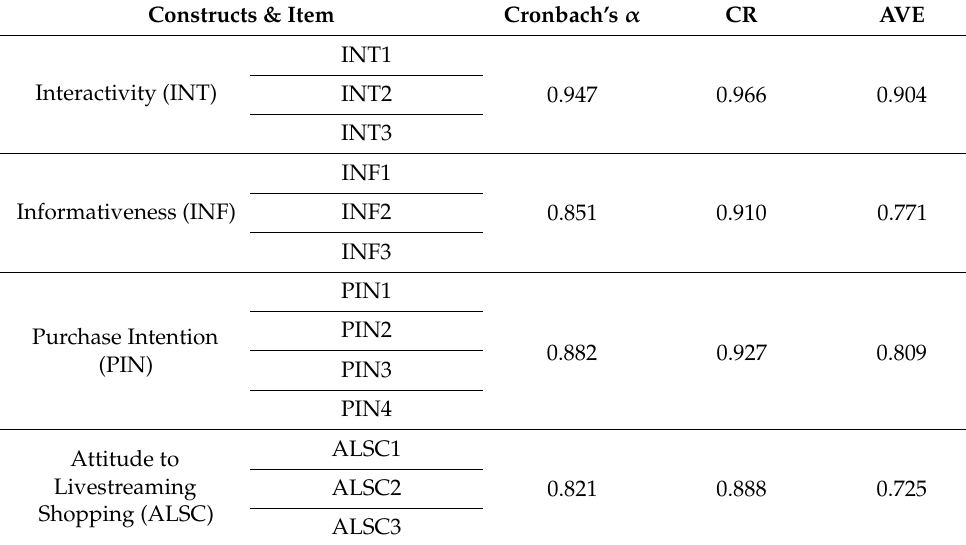
Table 4. Results of reliability and validity